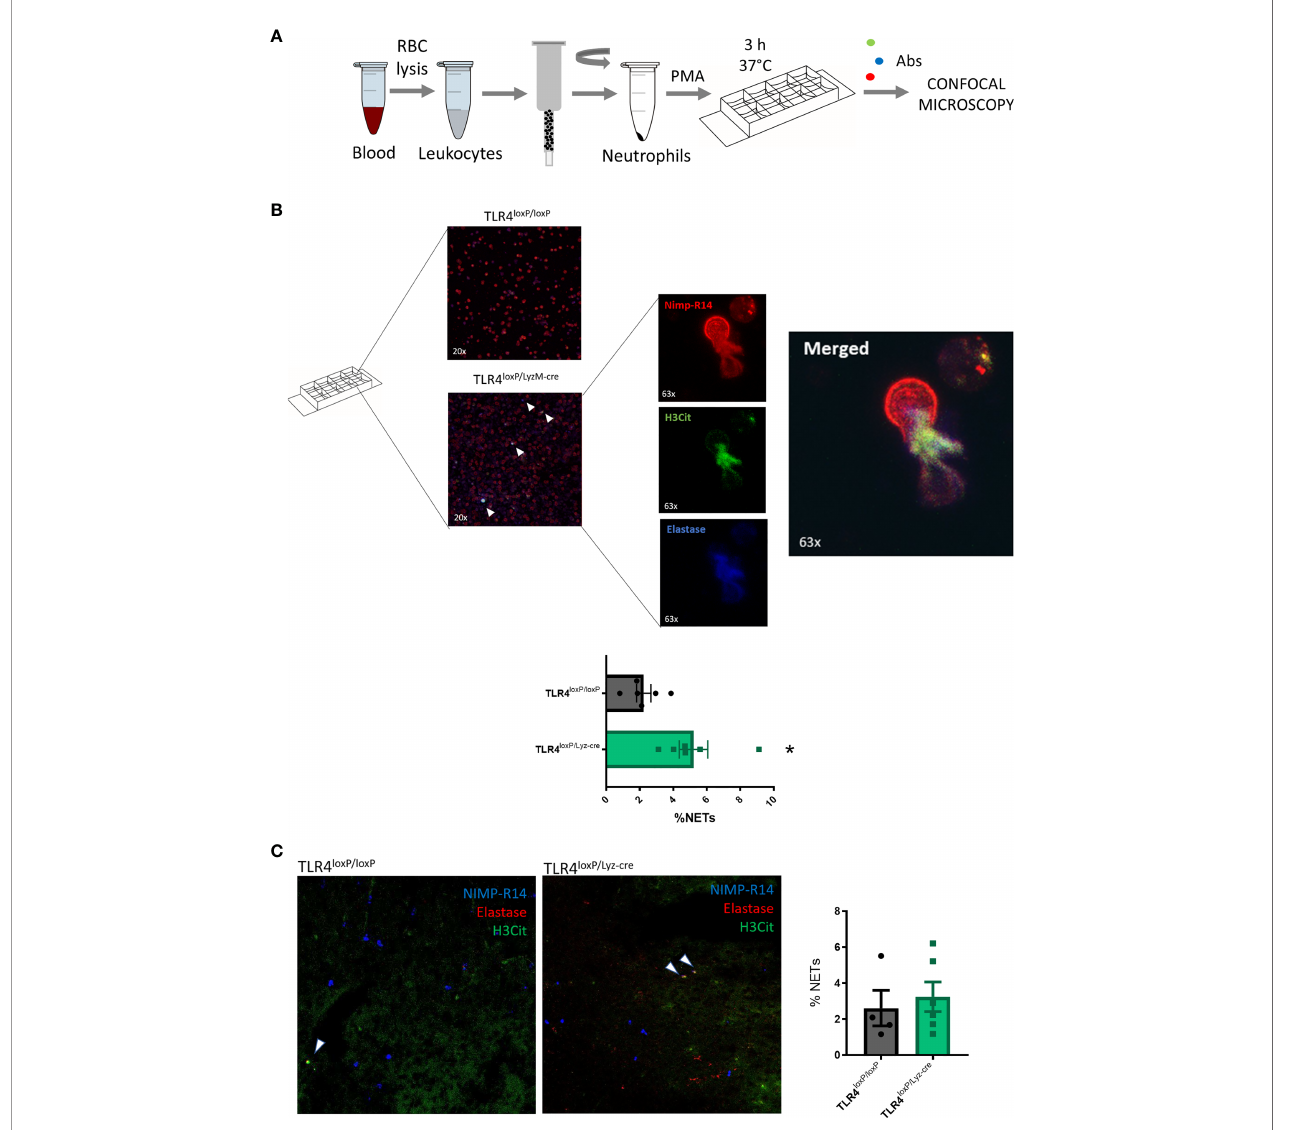
FIGURE 4 | Neutrophil Extracellular Trap formation. (A) Experimental design: blood was collected, RBC lysed, and neutrophils sorted and stimulated with PMA. Samples were incubated for 3 h at 37°C. After incubation time, cells were washed, fi xed and stained for NIMP-R14, H3Cit and Elastase. (B) Micrographs of neutrophils treated with PMA from TLR4 loxP/loxP and TLR4 loxP/Lyz-cre mice. NETs are marked with white arrowheads. 63x zoomed images show a neutrophil extruding its content releasing the NET. (C) Percentage of NETs (NIMP-R14 + /H3Cit + /Elastase + ) from TLR4 loxP/loxP and TLR4 loxP/Lyz-cre mice (*P < 0.05 vs TLR4 loxP/loxP ; n=6). Data are mean ±